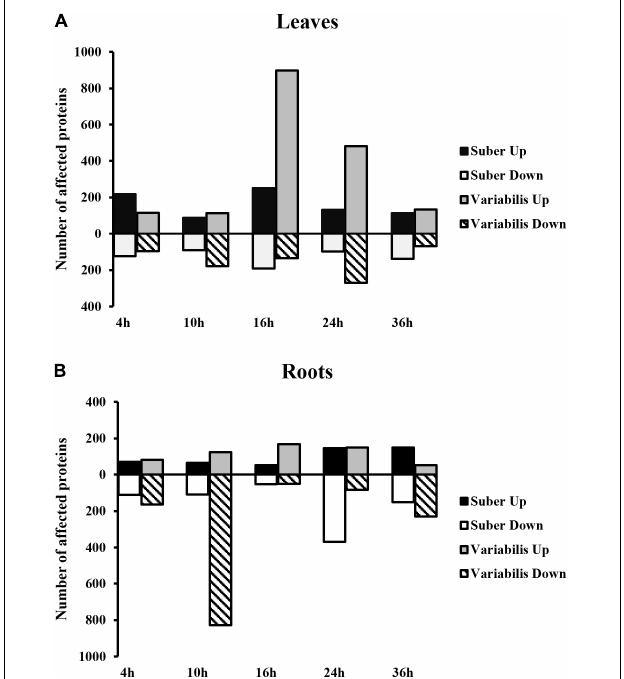
FIGURE 2 | Number of proteins with affected abundance in the leaves (A) and roots (B) of Q. suber and variabilis plants after inoculation with P. cinnamomi.